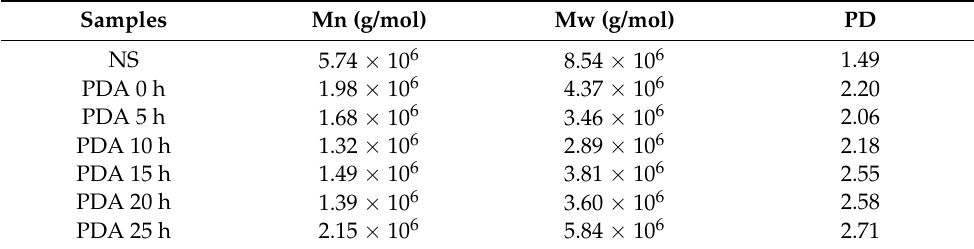
Table 2. Molecular weight of native and debranched combined with autoclaved starches.